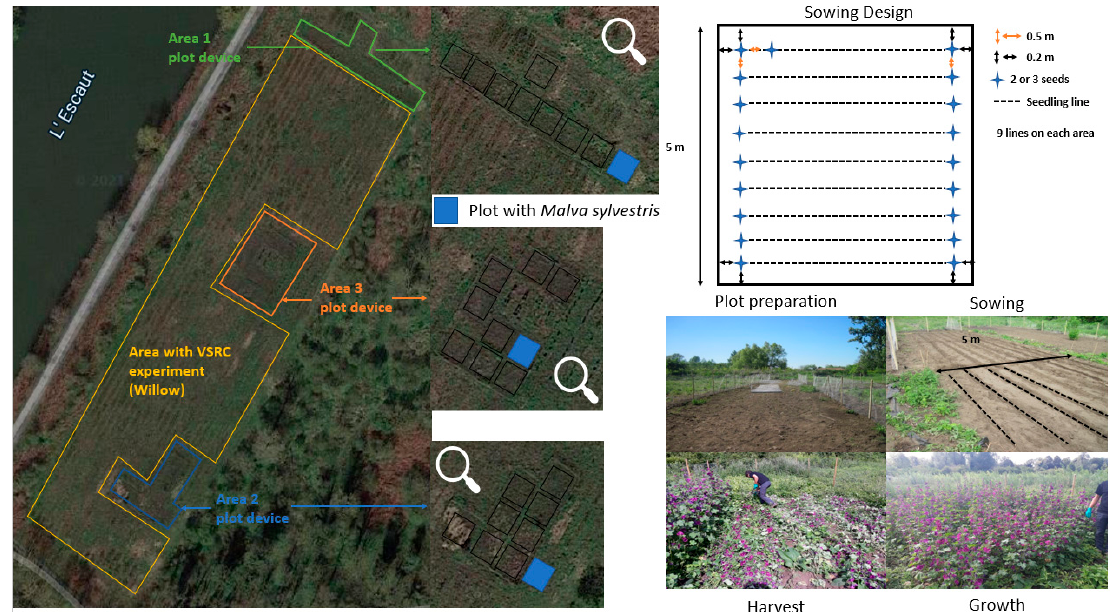
Figure 1. Aerial pictures of the site experiment and the plot device with the different areas (VSRC: very short rotation coppice; Area 1; Area 2; and Area 3), Malva sylvestris L. sowing design, and pictures of the different actions realized on the field.